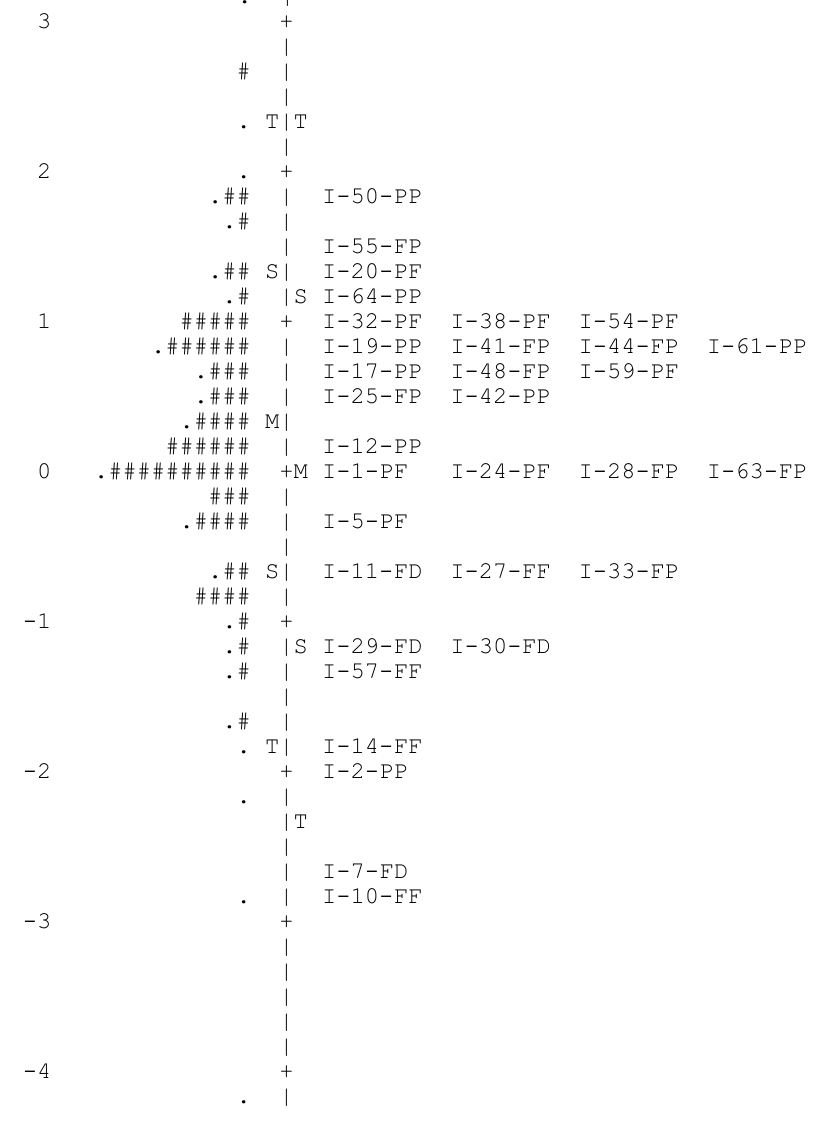
Figura 5 . Mapa do construto para o teste individual. Nota . Cada “#” são 3. Cada “.” é 1 ou